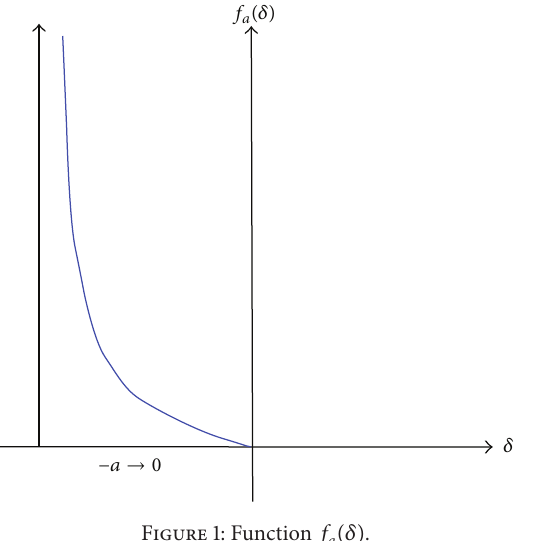
Figure 1: Function 𝑓 𝑎 (𝛿)